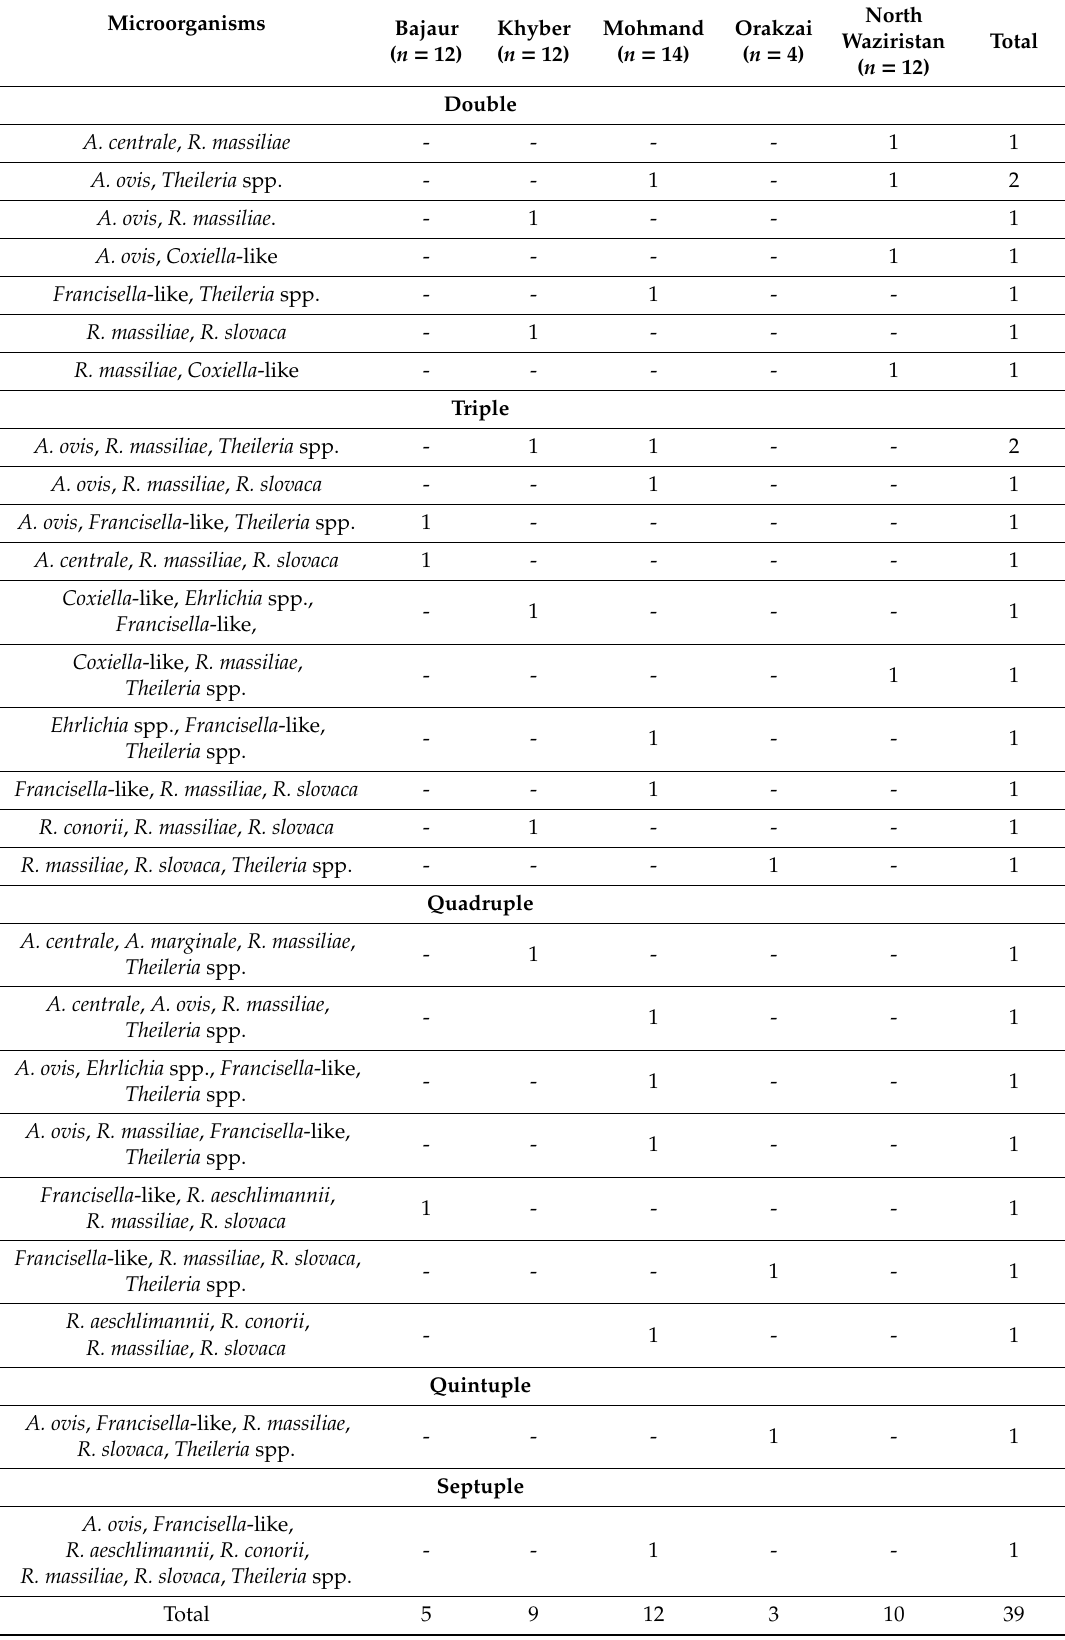
Table 4. Cont. Number of Ticks Positive for Single and Mixed Infections Microorganisms